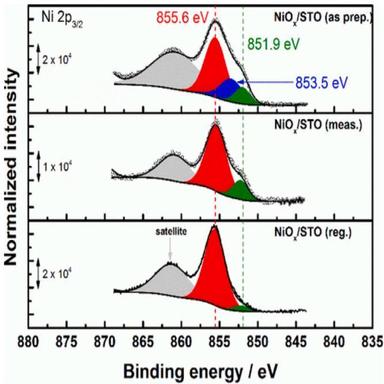
XPS spectra of the Ni 2p3/2 region of the BSTO1000-NiOx sample: (Top) before illumination Ni@NiOx/STO, (Middle) after illumination Ni@NiOx/STO, and (Bottom) after regeneration (48 h) Ni@NiOx/STO.